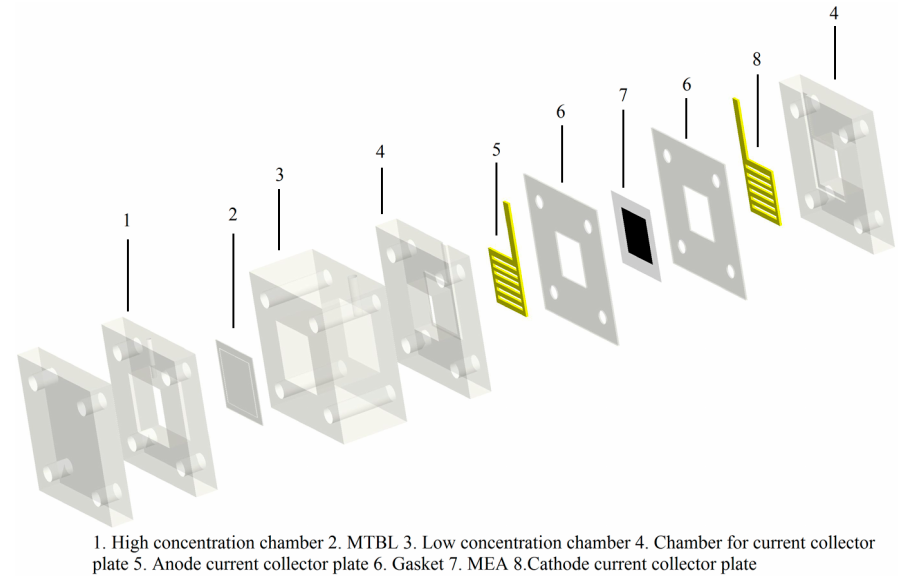
Figure 1. The structure of the micro direct methanol fuel cell ( μ -DMFC) using high concentration methanol solution as